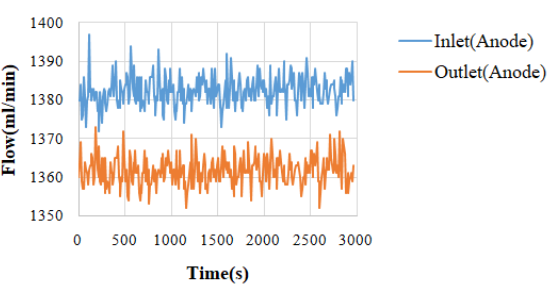
Figure 4. Flow chart of high-temperature fuel cell inlet and outlet (anode side).